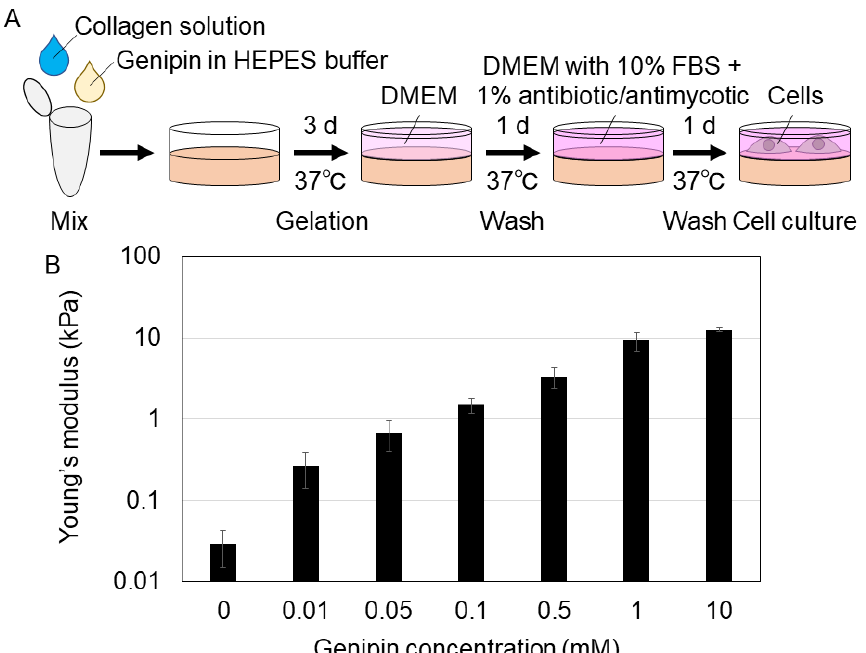
Figure 1. ( A ) The schematic procedure of preparing genipin-mixed collagen gels for cell culture. HEPES: N-2-hydroxyethylpiperazine-N-2-ethane sulfonic acid, DMEM: Dulbecco’s modified Eagle’s medium, FBS: fetal bovine serum. ( B ) Young’s moduli of the 0, 0.01, 0.05, 0.1, 0.5, 1, or 10 mM genipin-mixed collagen gels. Mean ± S.D. N = 3 experiments.